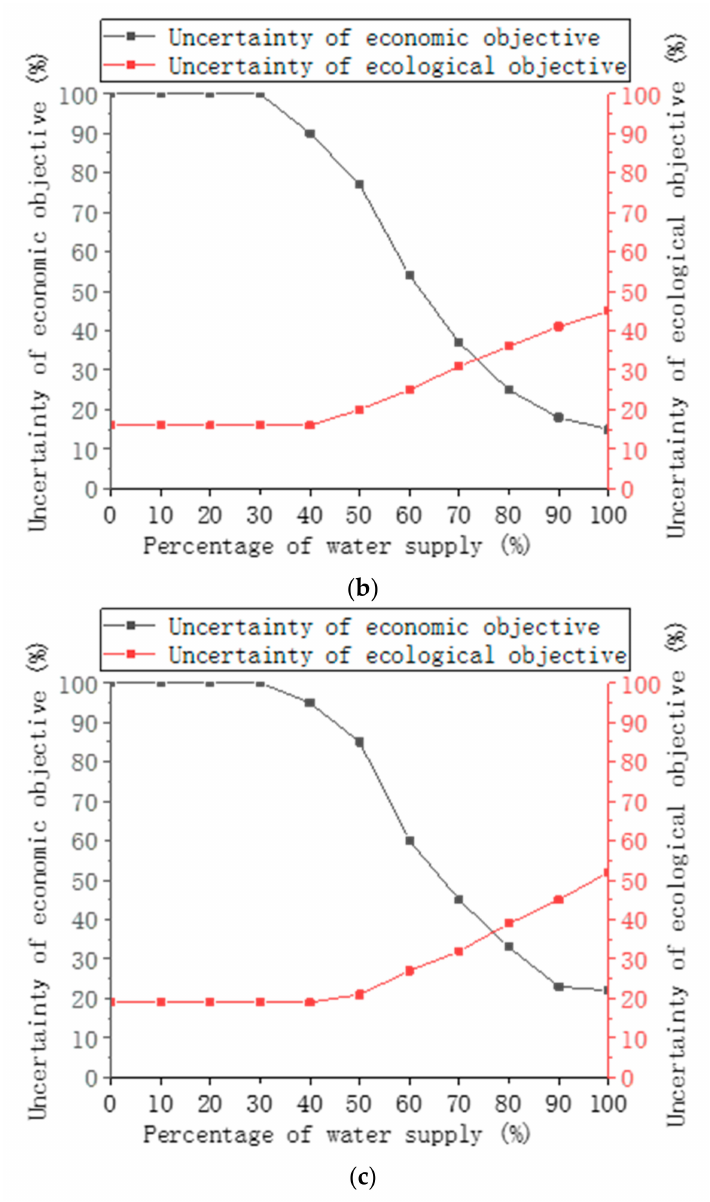
Figure 12. Response of uncertainty to percentage of water supply in September. ( a ) Wet years. ( b ) Normal-flow years. ( c ) Low-flow